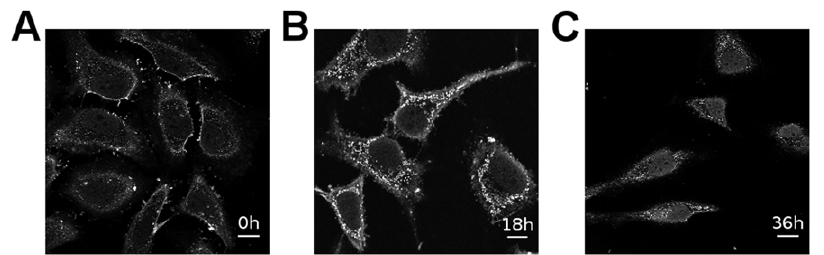
Figure 6. Accumulation of Max* in the nucleus of HeLa cells. Confocal immunofluorescence photomicrographs of HeLa cells incubated with Max* for 12 hours, washed and chased for 0 hour (A) 18 hours (B) and 36 hours (C). Cells were fixed, permeabilized and immunolabeled with anti- Max antibodies. Scale bar=10 m m.